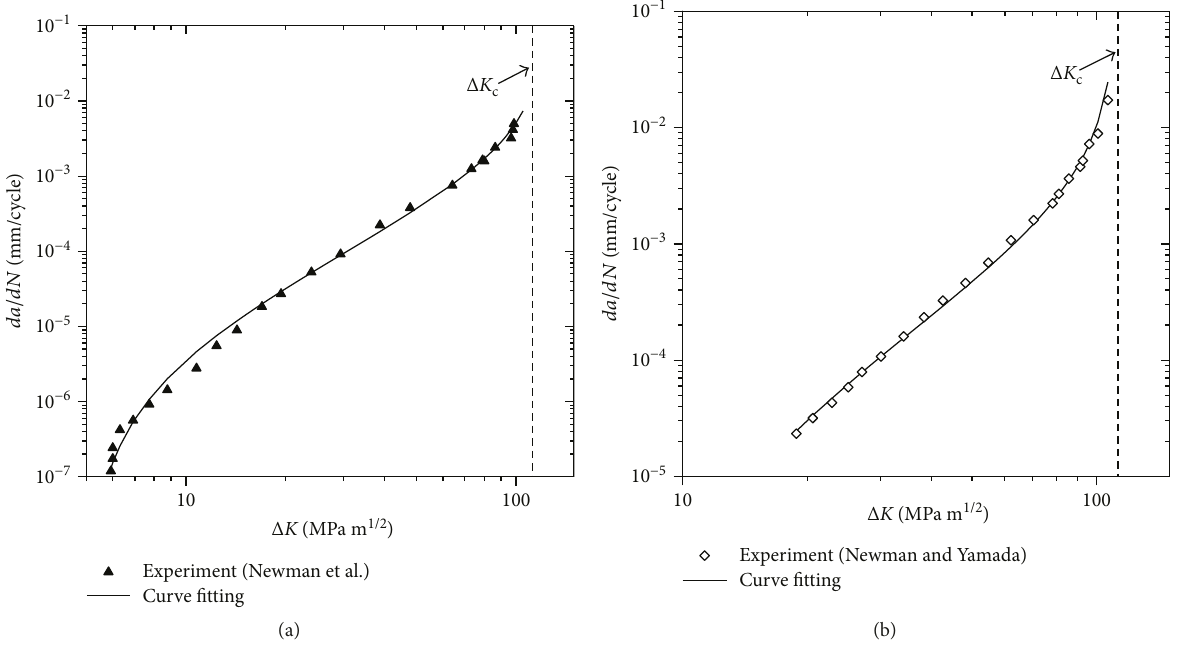
Figure 6: Plot of the experimental result and the corresponding fi tting curve by using the Erdogan-Ratwani model of the IN718 alloy for (a) the CT specimens and (b) the SEN